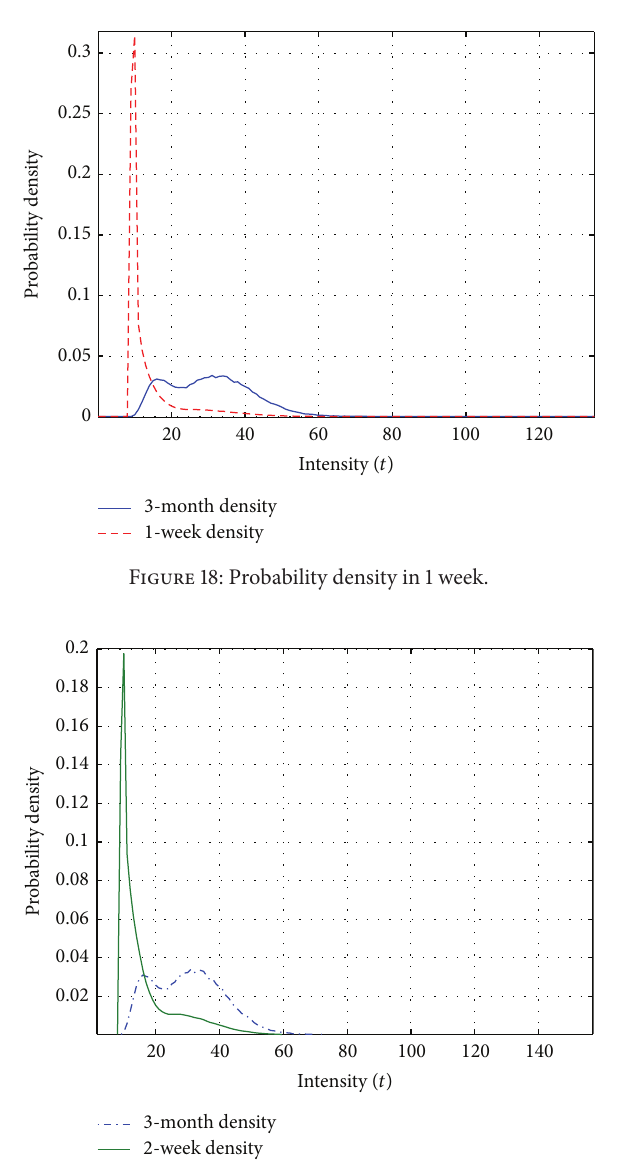
Figure 19: Probability density in 2 weeks.